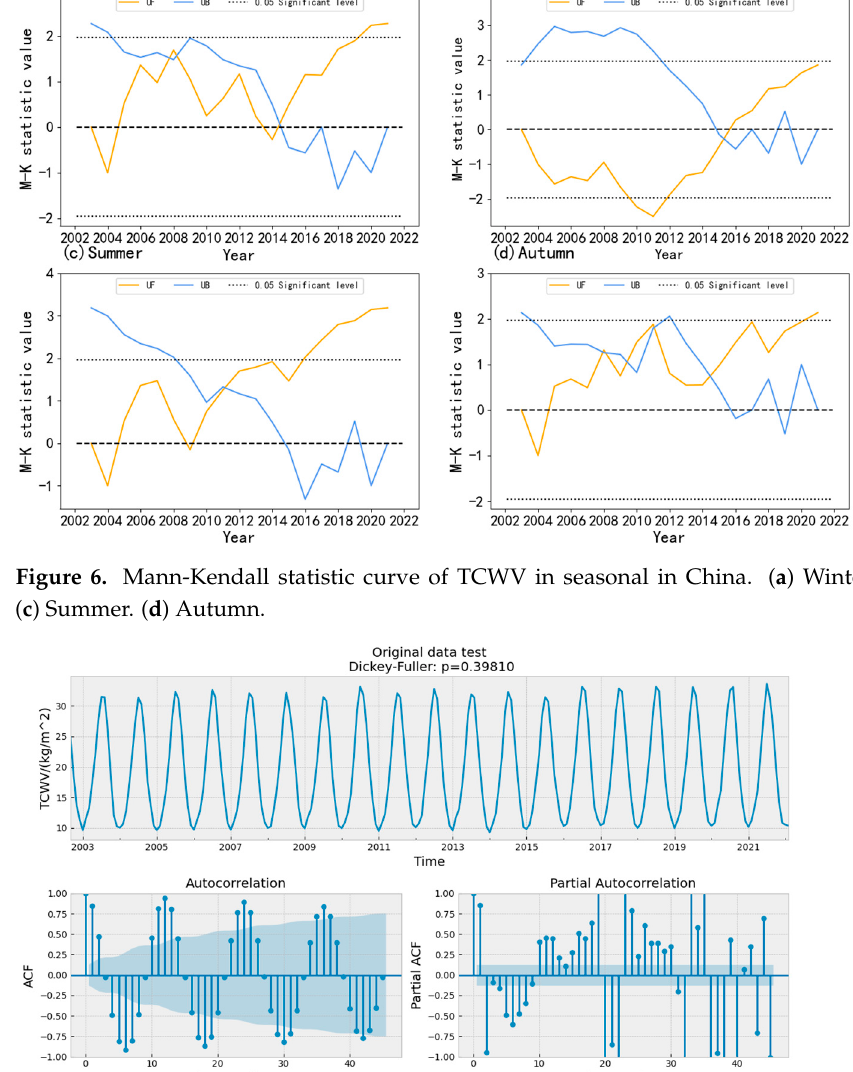
Figure 6. Mann-Kendall statistic curve of TCWV in seasonal in China. ( a ) Winter. ( b ) Spring. ( c ) Summer. ( d ) Autumn.